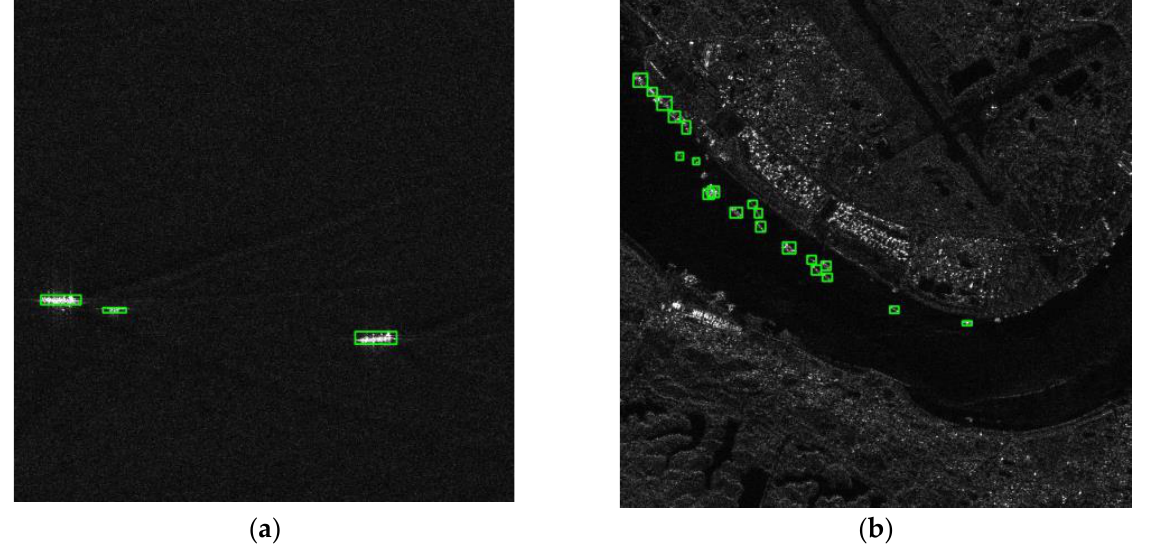
Figure 1. Two SAR image examples in different scenarios, with green boxes referring to ship objects labeled in the HRSID. ( a ) A simple off-shore image without interference; ( b ) a complicated image with inland interference and dense ships.